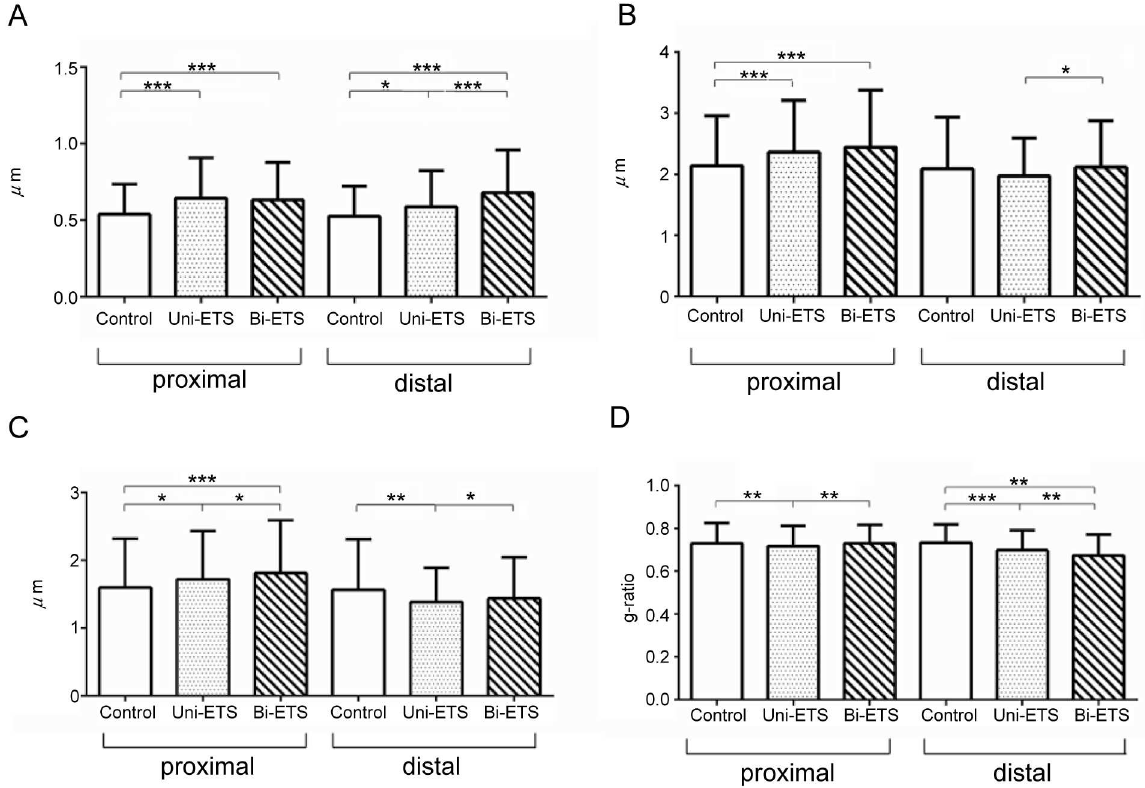
Fig 8. The morphometric parameters of regenerating axons. A) Myelin sheath in acellular nerve allografts containing migrated Schwanncells was thicker than that in the control group. Particularly,differences at distal section among all groups were significant. B) Myelinatedfiber diameter at proximalsection in the bilateralend-to-side(ETS) group was the largest, followedby the unilateral ETS and control groups. C) Axon diameter showedsimilar tendencyto myelinatedfiber diameterat both sections. D) G-ratio at proximalsection showeddifferencesamong the control, unilateralETS, and bilateralETS groups. In contrast, g-ratio at distal section revealeddifferences amongall groups. * p < 0.05, ** p < 0.01, *** p < 0.001.